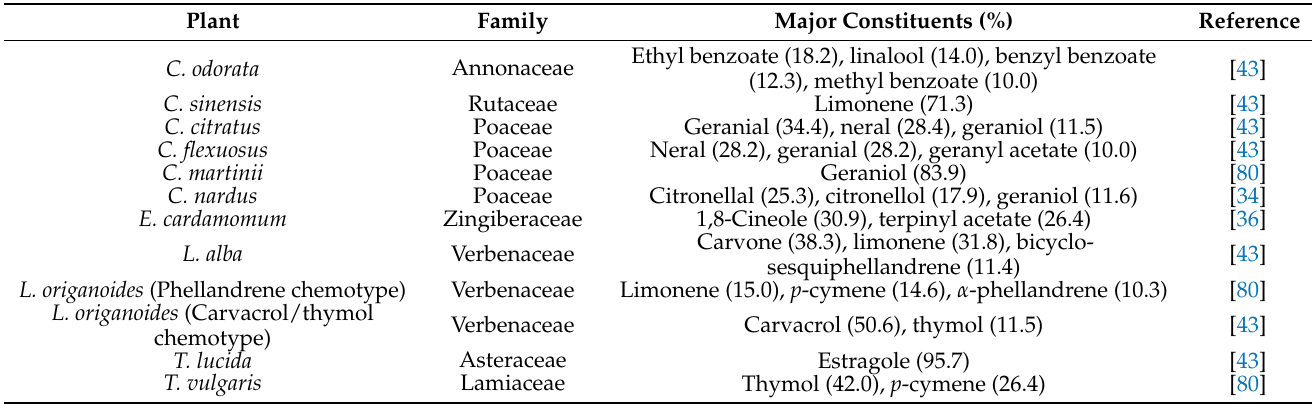
Table 4. List of the specimens studied. For each plant’s essential oils, the major constituents (>10%) are